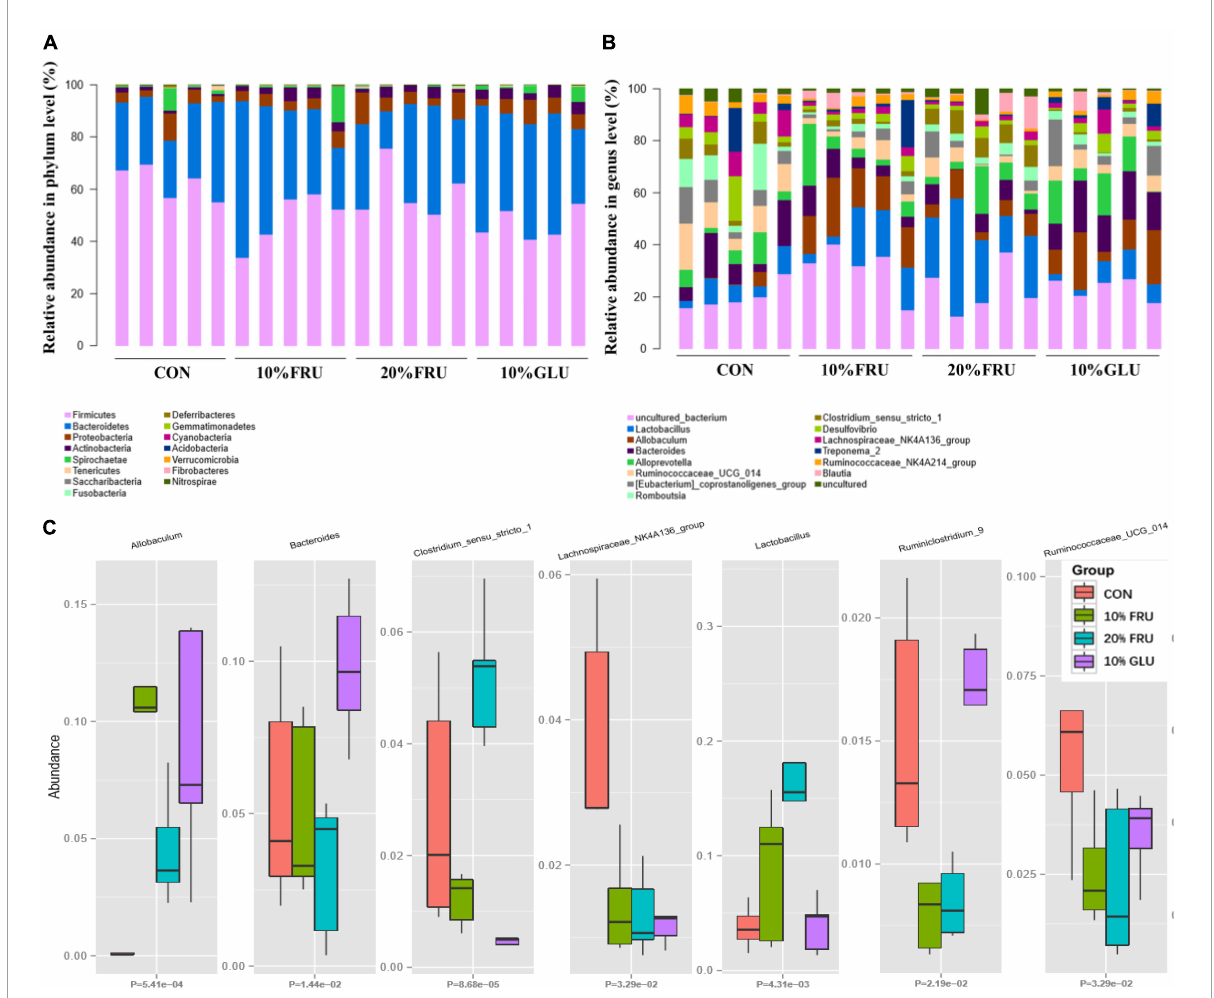
FIGURE4 Relative abundances of the gut microbiota at the phylum level (A) , genus level (B) and some different bacterial taxa ( Allobaculum, Bacteroides, Clostridium, Lachnospiraceae, Lactobacillales, and Ruminococcaceae ) obtained in fecal microbiota from the LefSe results (C) . Values were presented as mean ± SEM ( n = 5). Red color represented the CON group, green color represented the 10% FRU group, blue color represented the 20% FRU group, and purple color represented the 10% GLU